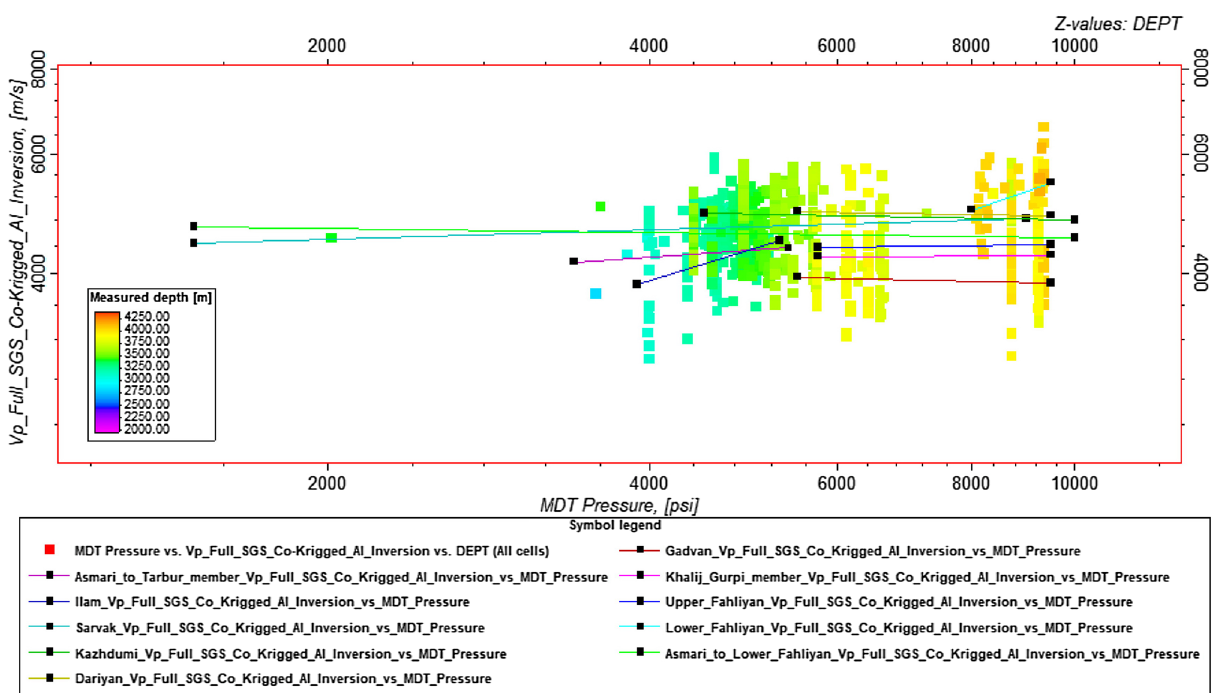
Fig. 7 Calculation of Bowers coefficients based on the MDT and DST effective pressure against the final Compressional velocity cube (VP_ Full_SGS and co-kriging with